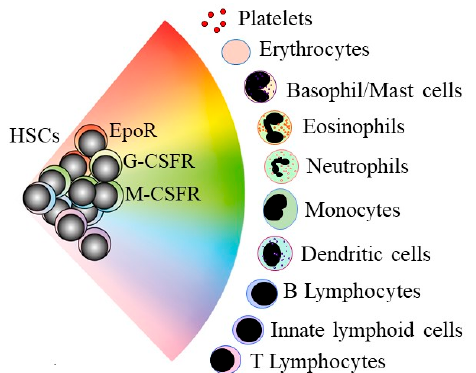
Figure 1. A continuum model for blood cell development. HSCs “choose” a lineage from a continuum of the variety of options. For mouse HSCs, the different colors show that they are a mixture of cells that selectively express the receptors for the lineage-affiliated cytokines erythropoietin (EpoR), granulocyte colony-stimulating factor (G-CSFR), and macrophage colony-stimulating factor (M-CSFR). HSCs and hematopoietic progenitor cells retain enough versatility to “step sideways” into a different pathway.